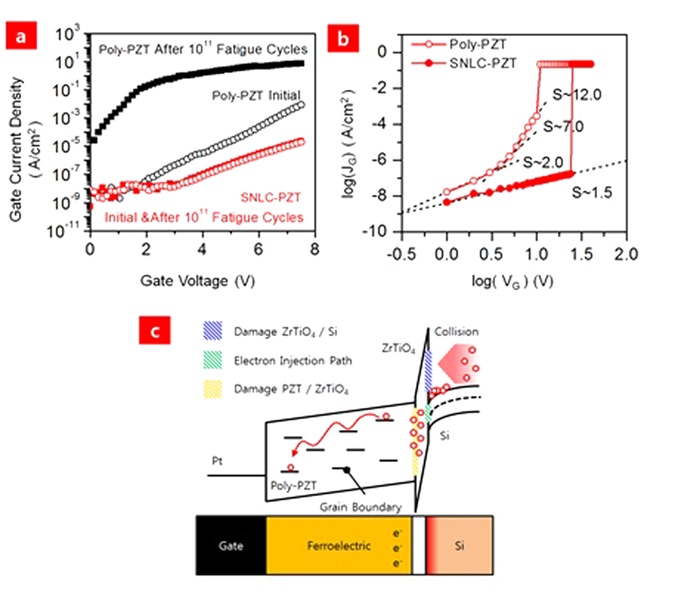
Grain boundary effect in the leakage characteristics.(a) Comparison of gate current density in poly- and SNLC-PZT at initial and after 1011 fatigue cycles. (b) The space-charge-limited conduction characteristics of poly- and SNLC-PZT. (c) Energy diagram for grain boundary effect in the gate leakage mechanism.